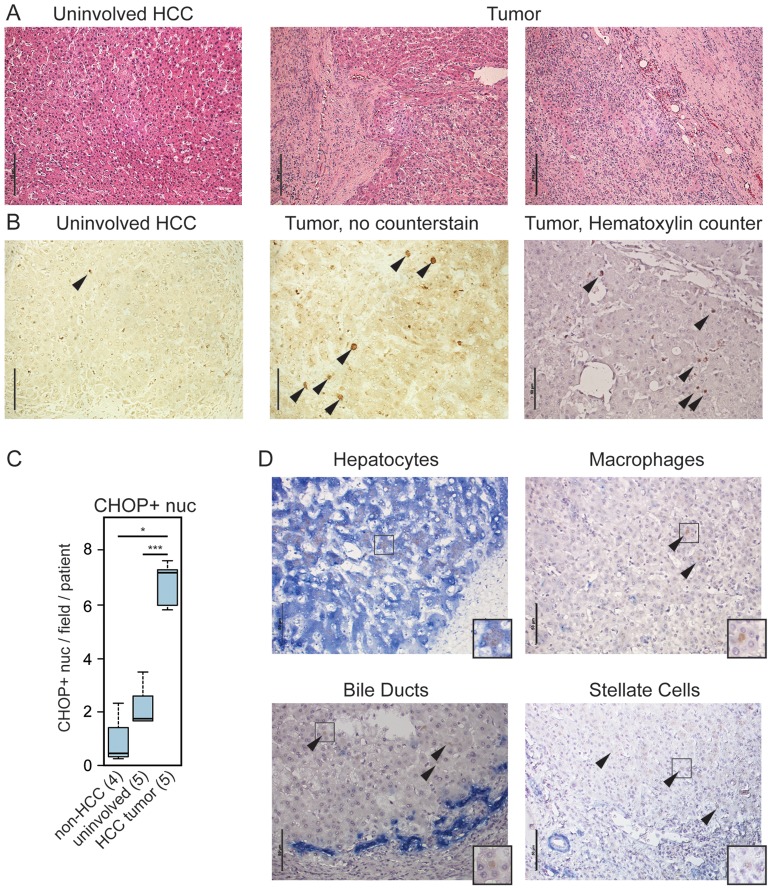
CHOP is expressed in human HCC tumors.(A) Histology of tumor-proximal liver (uninvolved HCC) and tumor (two regions) tissue from the same patient. H&E images are representative of 28 tumor samples and 5 uninvolved matched controls. For (A) only, scale bar = 100 µm (B–C) CHOP immunostaining is associated with human HCC but not uninvolved regions. (B) Samples from uninvolved tumor-proximal tissue and HCC tumors were probed for CHOP expression by immunohistochemistry. CHOP-positive nuclei are indicated by arrowheads. Cellular and nuclear architecture in some HCC samples was distorted as seen in the non-counterstained image, accounting for the large nuclei. Scale bar = 50 µm. (C) The average number of CHOP-positive nuclei per microscopic field per patient was quantitated blindly from 5 HCC tumors and their uninvolved matched controls, as well as from 4 non-HCC specimens, and these were aggregated by Boxplot. P-values were calculated by Asymptotic Wilcoxon Rank Sum Test. (D) HCC-associated CHOP is expressed in hepatocytes. Expression of CHOP (brown) and cell type-specific markers (blue) for hepatocytes (cytokeratin-18), macrophages (CD68), bile ducts (cytokeratin-7), or activated stellate cells (smooth muscle actin) is shown by immunohistochemistry, with a hematoxylin counterstain applied. Representative data are shown. Note that only hepatocytes show CHOP-positive nuclei; arrowheads are used to show CHOP-positive cells in other samples. Scale bar = 50 µm. Insets show 25 µm×25 µm regions with distinct CHOP-positive nuclei.